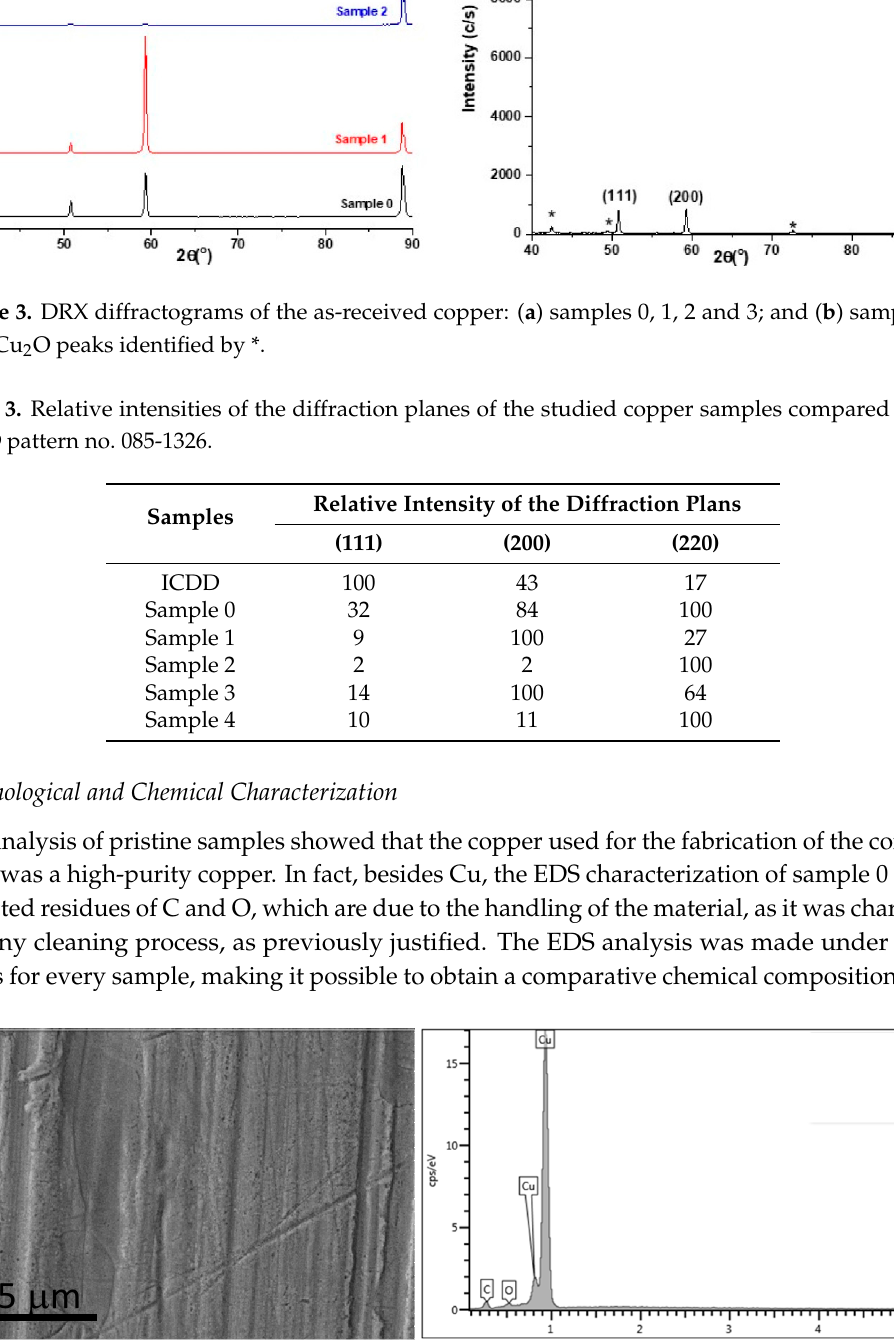
Table 3. Relative intensities of the diffraction planes of the studied copper samples compared with ICDD pattern no. 085-1326.